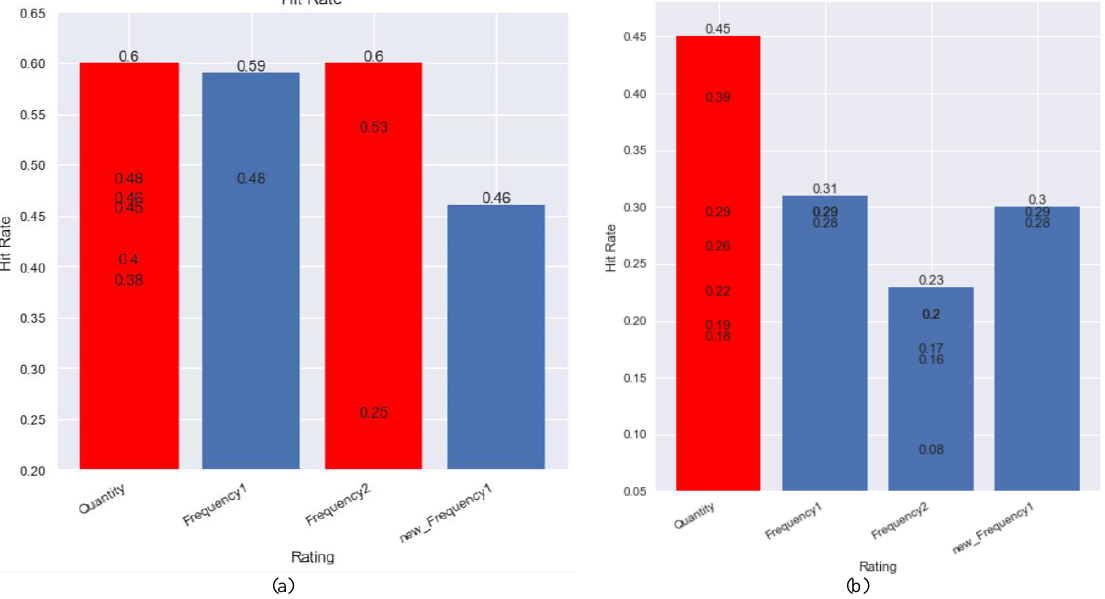
Figure 8. (a) LightFM HR per rating metric, (b) Surprise library HR per rating